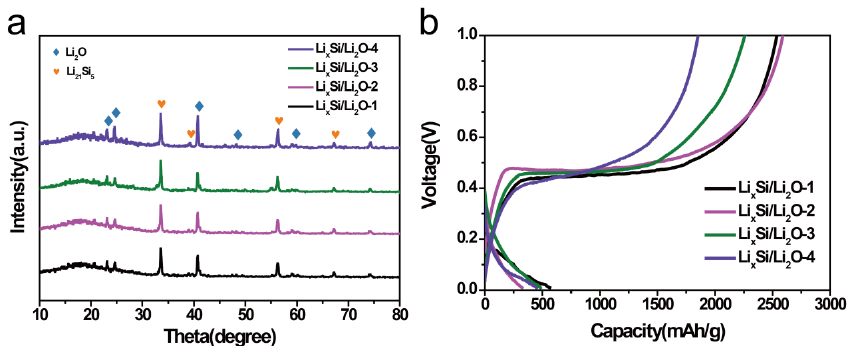
Figure 3. ( a ) XRD patterns of the four prelithiated composites; ( b ) The corresponding galvanostatic charge/discharge profiles of the Li x Si/Li 2 O samples at the first cycle.